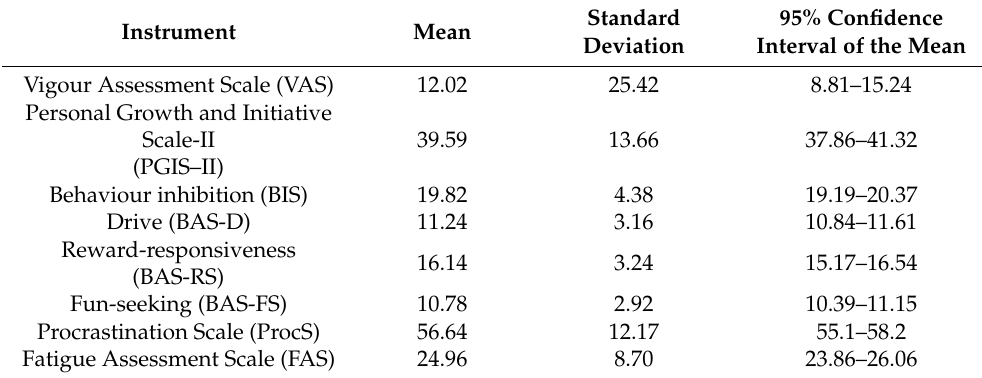
Table 3. Descriptive statistics for the instruments only in data set no. 3.